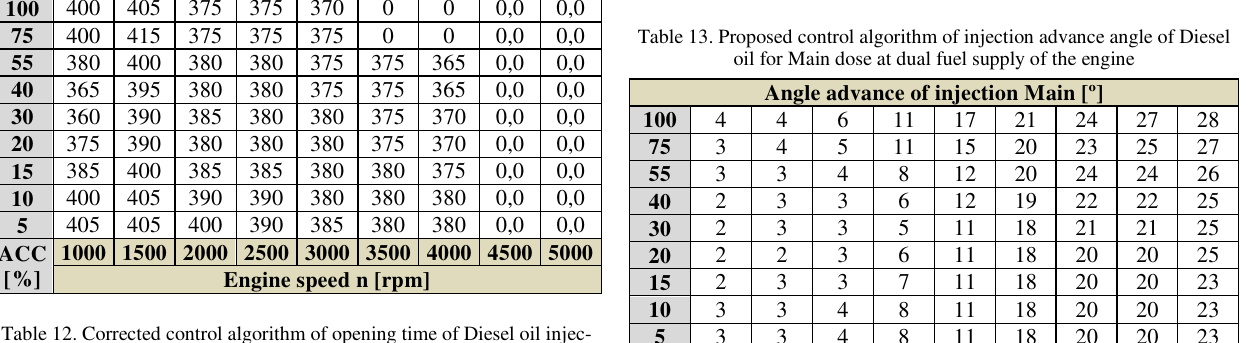
Table 11. Corrected control algorithm of opening time of Diesel oil injec- tors for Pre dose at dual fuel supply of the engine Pre injection timing – CNG [µs]